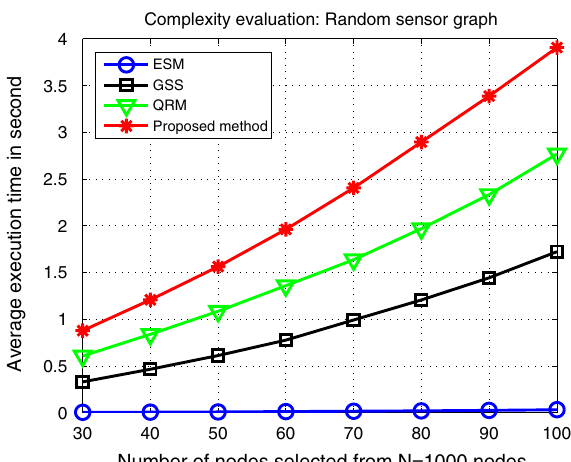
Fig. 6 Complexity evaluation in terms of average execution time in second for RSG by varying the sample size, | S |